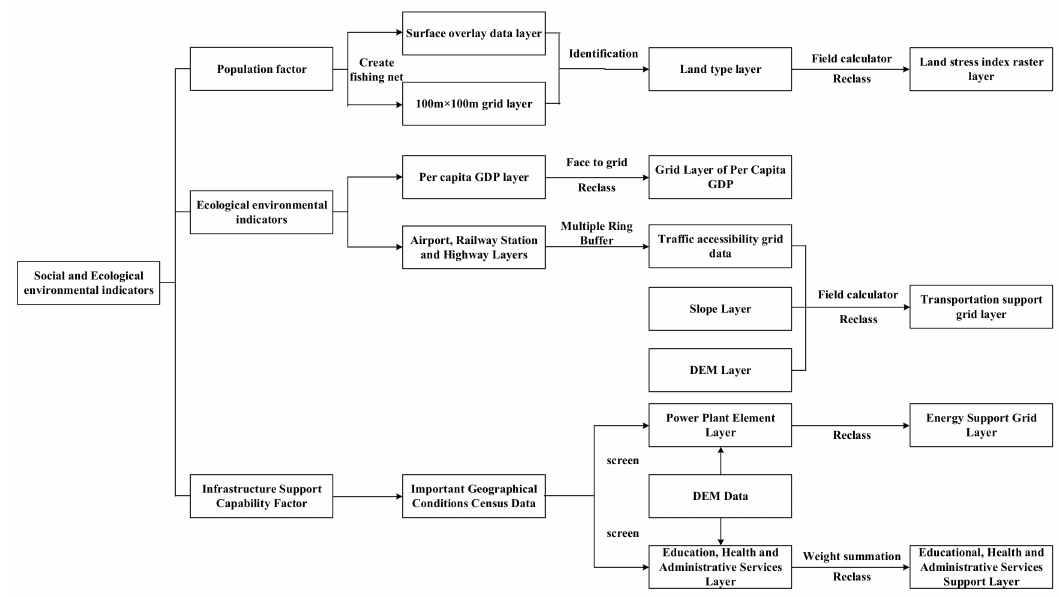
Figure 5. Processing flow chart of social and economic indicators.